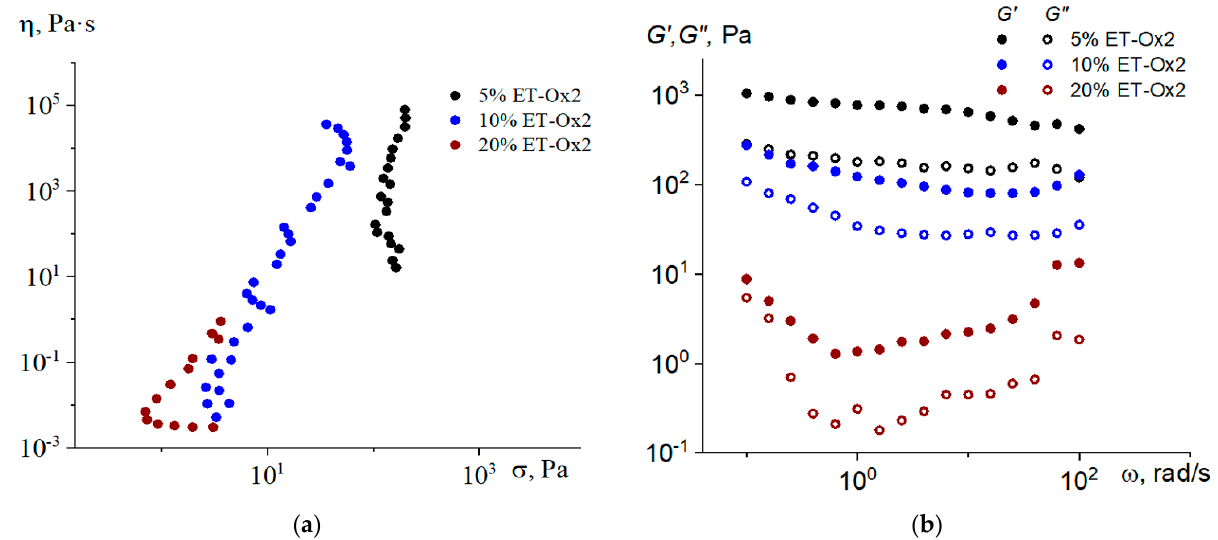
Figure 4. Dependence of viscosity on shear stress ( a ) and frequency dependences of storage and loss moduli ( b ) of paraffin composites containing ET ‐ Ox2 asphaltenes, T = 80 °C.